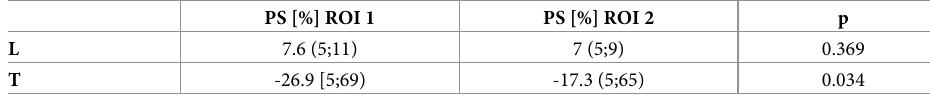
Table 2. Radial and longitudinal peak strain of regions of interest both ROI reflecting the atria.